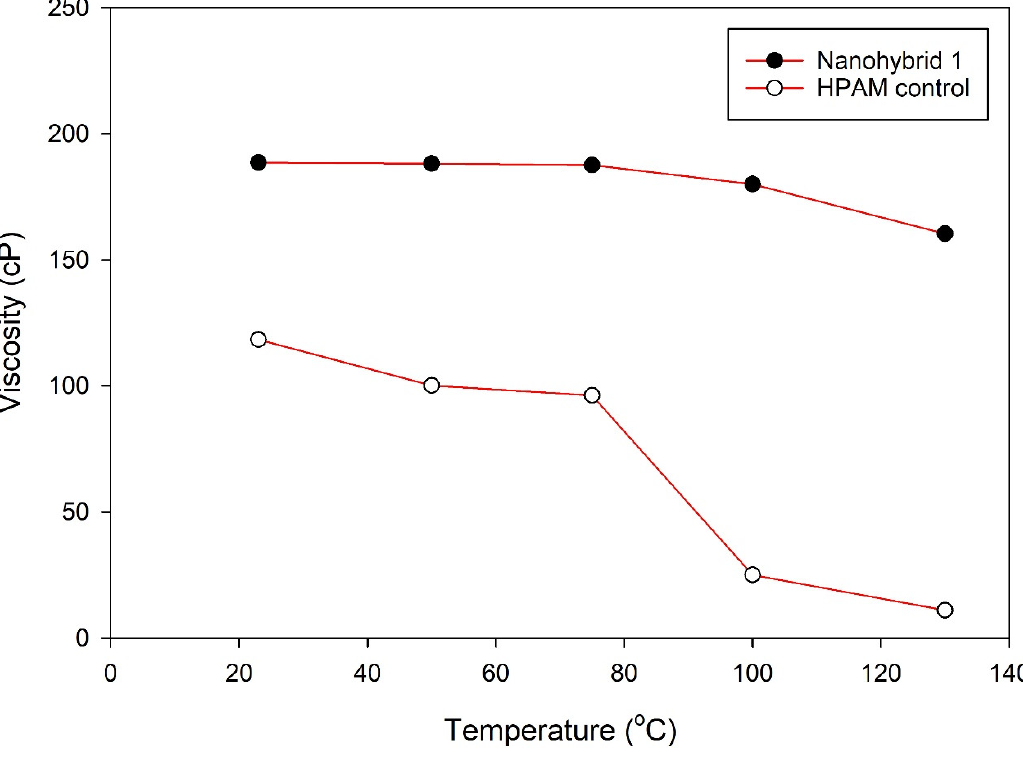
Figure 8. Temperature effect on nanohybrid 1 and HPAM polymer solution. Shear rate = 10 s -1